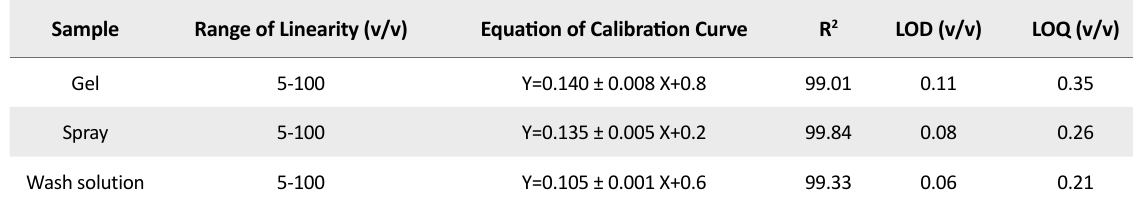
Table 3. Values of LDR, LOD, and LOQ for ethanol in gel spray and wash solutions